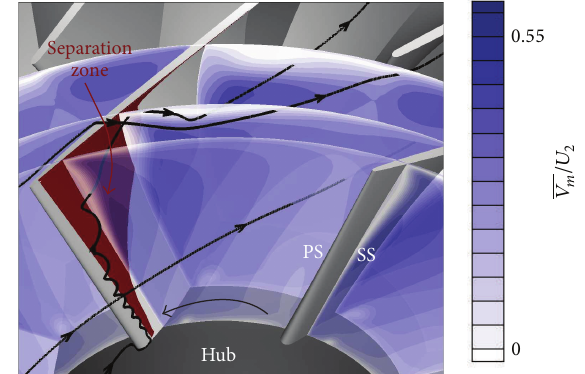
Figure 6: Time-averaged reduced meridional velocity contours for the near stall operating